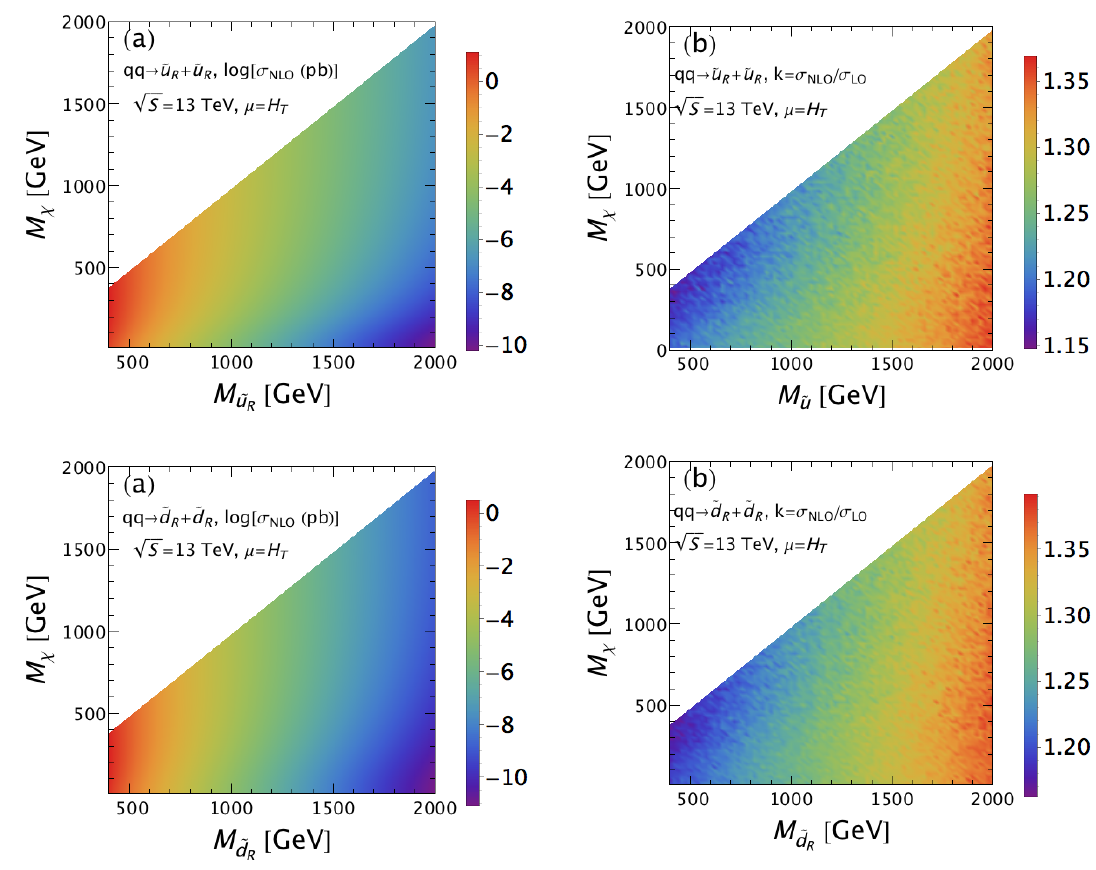
Figure 9 . The production cross section and k -factor for mediator pair production via dark matter exchange in the u R model (upper) and d R model (lower) at the 13 TeV